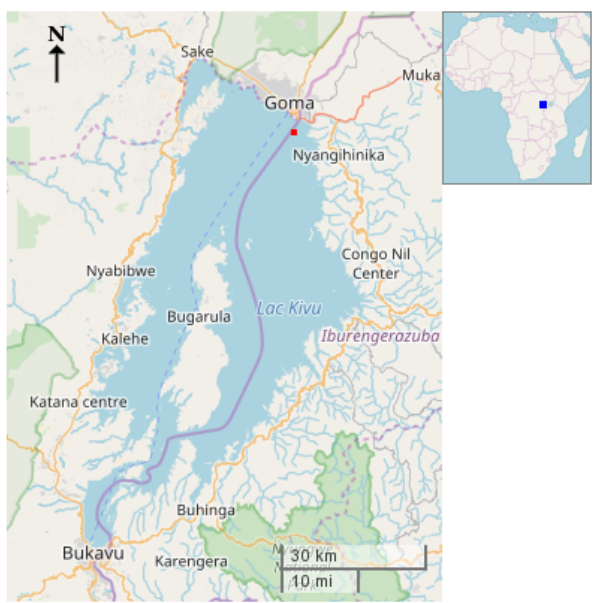
Figure 1. Maps of Lake Kivu geography and situation. The lower left corner of the large map is at 2.6 ◦ S, 28.7 ◦ E, and the upper right corner is at 1.5 ◦ S, 29.5 ◦ E. The lake is approximately 90km long and 50km wide. The purple line along the lake indicates the boundary between the Democratic Republic of the Congo to the west and Rwanda to the east. The weather station is situated ap- proximately 3km offshore, near Goma at the northern end of the lake. Its position is marked with a red square. The location of Lake Kivu within Africa is marked on the small map by a blue square. (©OpenStreetMap contributors. Mapping data are available under the Open Database